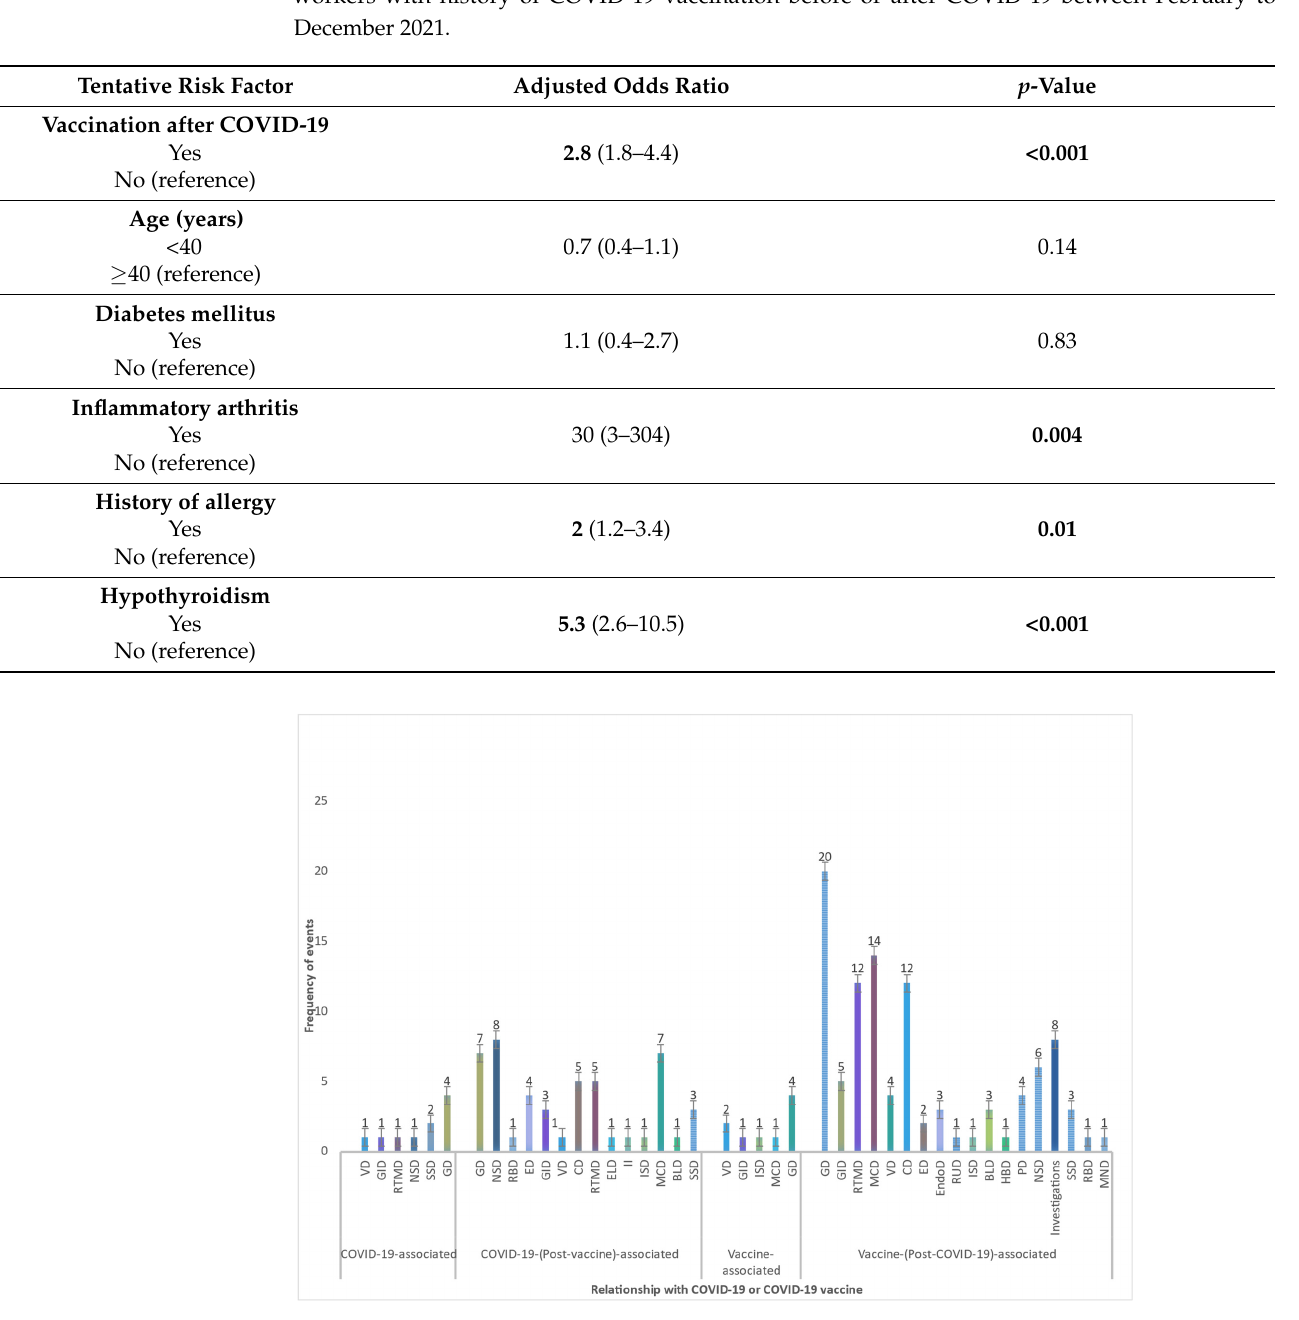
Figure 3. System organ class (SOC) of persistent health issues and their relationship with COVID-19 or COVID-19 vaccine. Analysis period: February 2021 to December 2021. [ MedDRA SOC Ab-